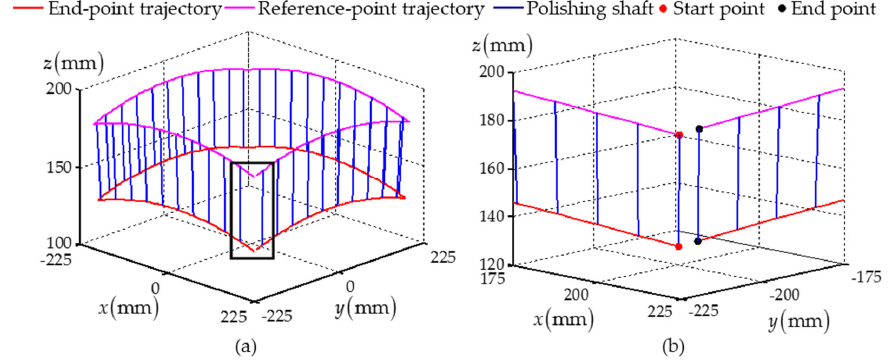
Figure 3. The initial fitted polishing trajectory for fairing optimisation and interpolation ( a ) the fitted polishing trajectory ( b ) the partial enlarged view.